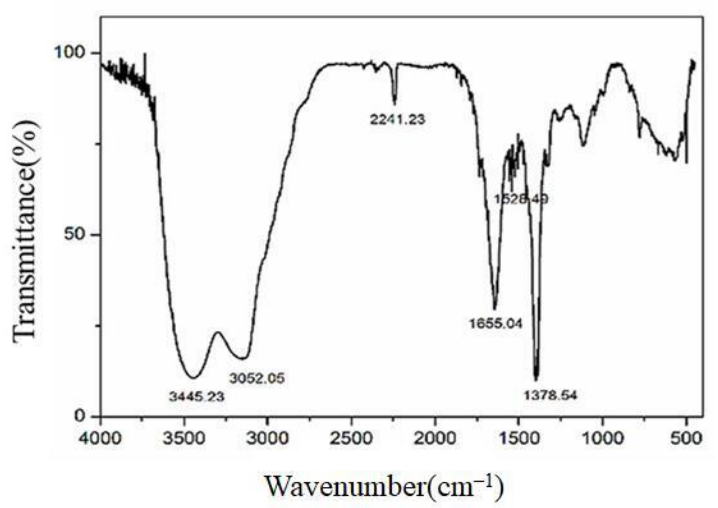
Figure 4. FT-IR spectrum of